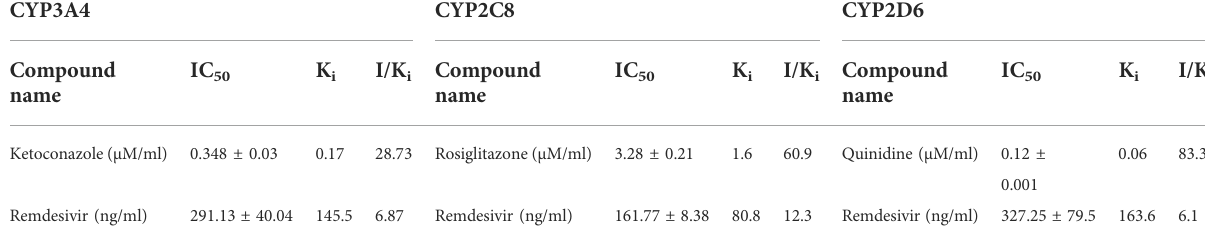
TABLE 2 IC 50 values of standard CYP substrate inhibitors and remdesivir for CYP3A4, 2C8, and 2D6 isoenzymes.